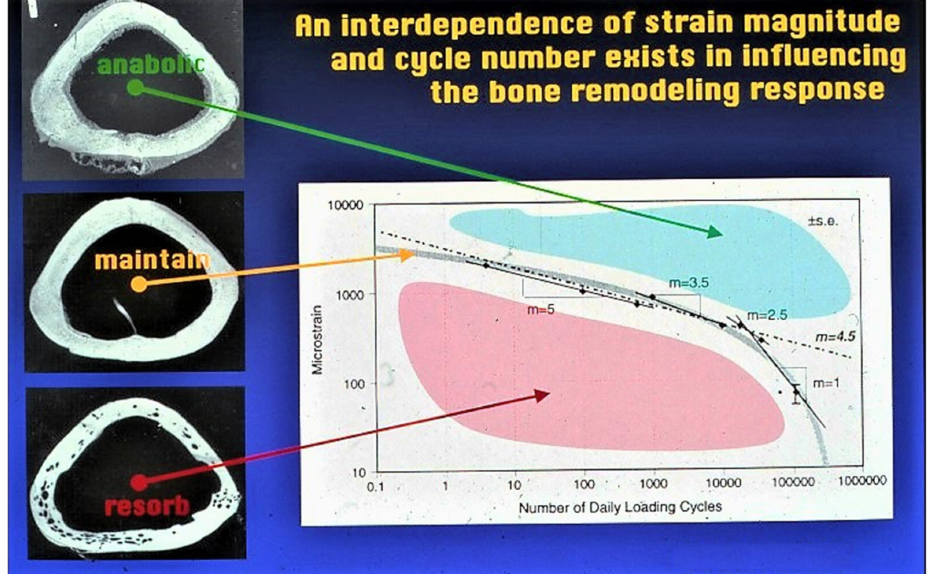
Figure 1. A biomechanical example of how bone responds to physical forces, demonstrating relation- ships between strain amplitude and frequency on bone mass. An optimal relationship has been found in this model with hypertrophy (blue) and atrophy (red) occurring with increased and decreased strain, respectively. Adapted with permission from Ref. [2]. 1998, Journal of Orthopaedic Research .